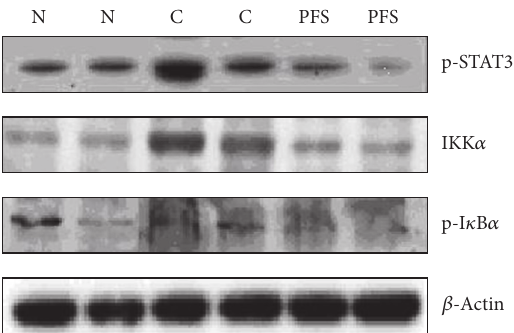
Figure 3: Effect of PFS treatment on protein expression levels of p-STAT3, IKK 𝛼 , and p-I 𝜅 B 𝛼 protein expression levels in the AIA rat model. AIA was induced as described in Methods. Arthritic rats were treated with 50 mg/kg PFS for 35 days. In day 28 off-target organs paws were processed and protein lysates were probed for expression of p-STAT3 and related NF- 𝜅 B family members (IKK 𝛼 and p-I 𝜅 B 𝛼 ) by Western blotting. N: normal; C: